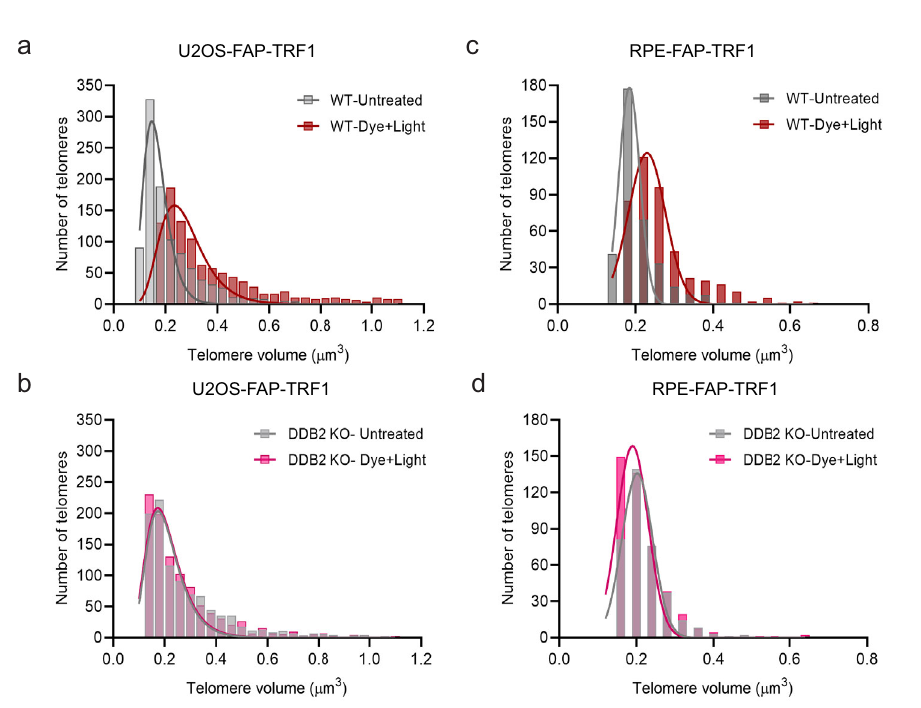
Fig. 6 DDB2 mediates chromatin decompaction at sites of telomeric 8-oxoG. a , b Distribution of the largest 20% telomeres in untreated and dye plus light treated U2OS-FAP-TRF1 WT and DDB2 KO cells. Cells were fi xed 30 min post treatment. c , d Distribution of the largest 20% telomeres in untreated and dye plus light treated RPE-FAP-TRF1 WT and DDB2 KO cells. Cells were fi xed 30 min post treatment. Source data are provided as a Source Data fi le. (See also Supplementary Fig. 7, Supplementary Movie 1 and